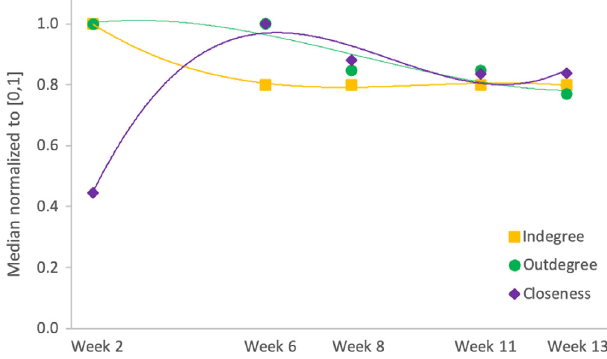
FIG. 6. Scatter plot of the centrality median change (with polynomial trend lines) for indegree (yellow square), outdegree (green circle), and closeness (purple diamond), shown chrono- logically. To compare the overall trend, the median values are normalized to [0, 1] for each centrality. We observe a general trend of decreasing median value for all presented measures, with equilibrium reached around week